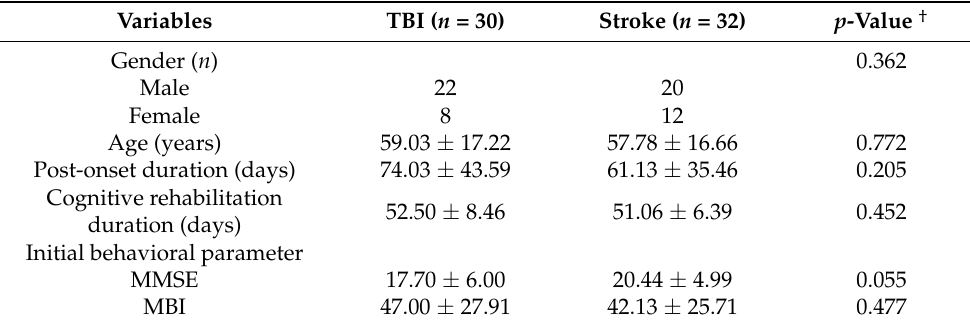
Table 1. Descriptive statistics for TBI and stroke groups.